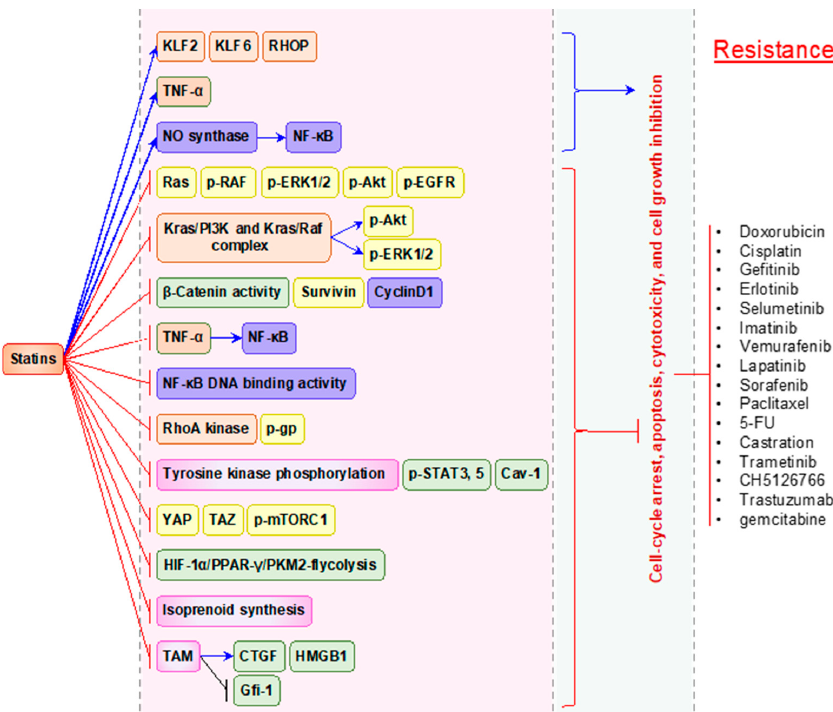
Figure 4. Statins for overcoming anti-cancer drug resistance. Statin overcomes the resistance devel- oped by various anti-cancer drugs (as indicated in the figure) through the induction of cell-cycle arrest, apoptosis, cytotoxicity, and inhibition of cell growth. In most cases, statin inhibits the sig- naling molecules or kinases involved in cancer cell proliferation, growth, metastasis, angiogenesis, inflammation, and multi-drug resistance mechanism developed by those anti-cancer drugs. Blue arrows indicate upregulation, red colored lines indicate